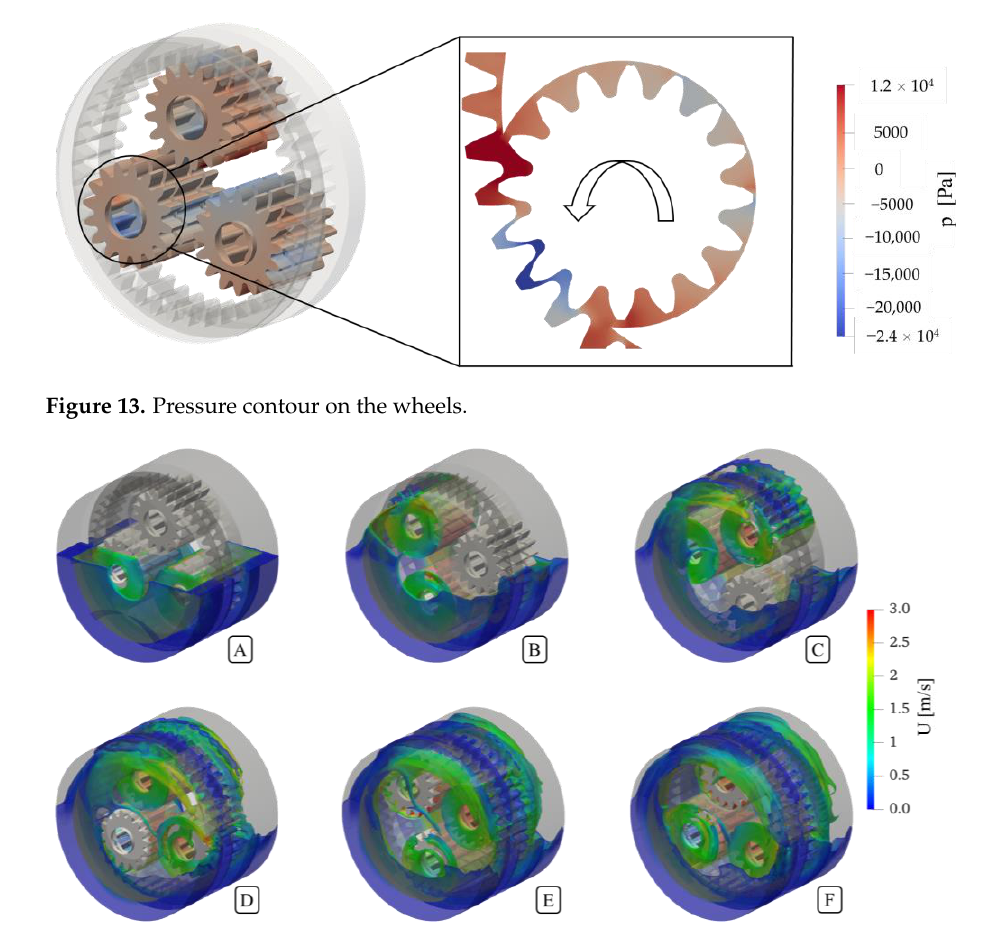
15 of 18 Figure 12. Oil distribution inside the gearbox for the analyzed operating conditions. Top row: low filling level cases. Bottom row: high filling level cases. Axial flows (squeezing effect) and oil rings around the planets are highlighted. For the low filling level cases (top row), the oil is dragged from the sump and deliv- ered to the other parts of the gearbox. As the rotational velocity increases, more oil partic- ipates to the lubrication and the ring gears receive a greater amount of oil. For the high filling levels (bottom row), oil rings also originate around the planet gears, as illustrated in Figure 12. These are generated by the roto-translation of the planets which are com- pletely submerged when they are below the centerline of the gearbox. As they move above the centerline, the oil remains entrapped between the planets and the planet carrier, and the roto-translation of the wheels promotes the formation of these additional oil rings. The faces of the gears remain wet, and the cylindrical shape of the gear shafts contribute to the rotatory movement of the oil around the wheels. The squeezing effect that can be seen in all cases derives from the mutual interaction between the planets and the ring gears. The squeezing of the oil from the planet – ring gear meshing zone was also observed by Boni et al. [8]. The CFD simulations provide a physical explanation for these axial fluxes. Indeed, while the gears engage, the gap between the teeth reduces and increases continuously during the gear mesh. The sudden contraction of this volume implies an overpressure in the gap that gives origin to axial fluxes. After reaching the minimum value for the volume, the volume of the gap suddenly increases again causing a lower pressure in the gap (it should be considered that the pressure drop is significantly smaller than environment pressure of 1 bar, and, therefore, this pressure